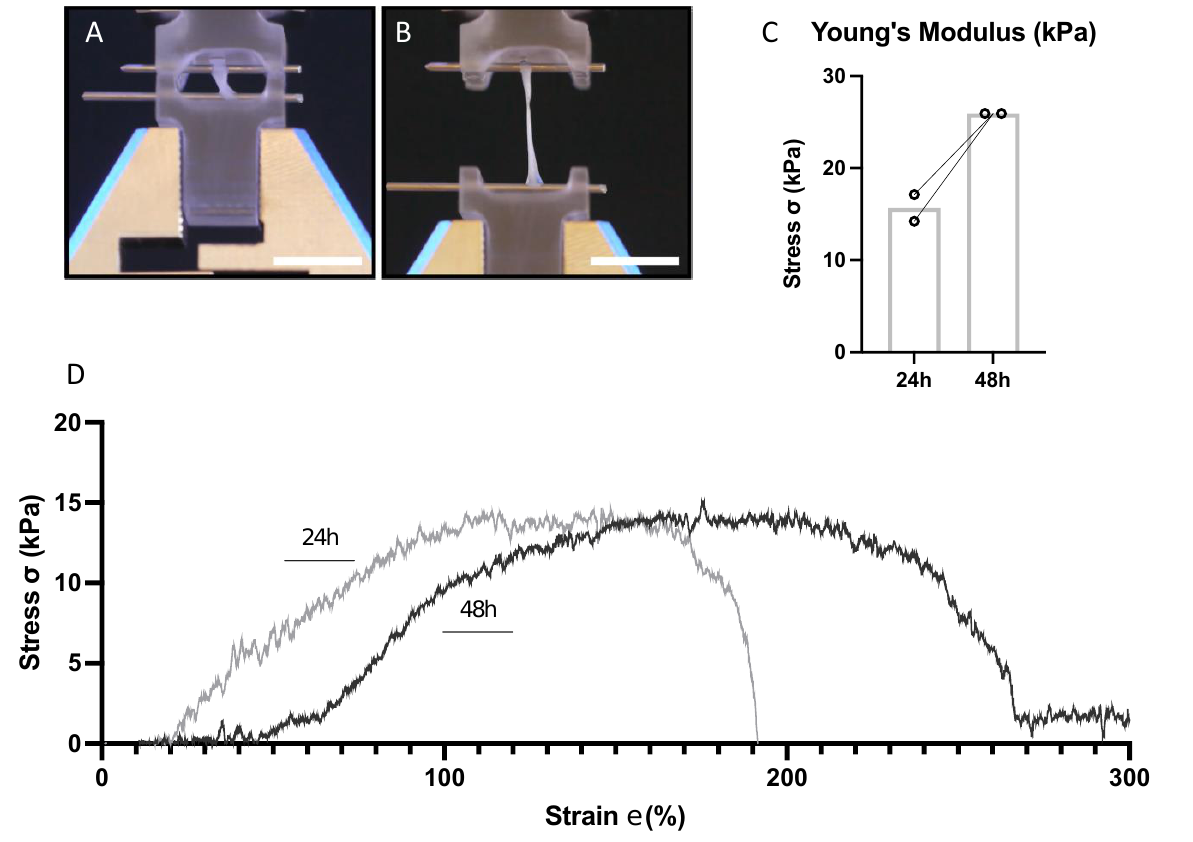
Figure 5. Stiffness measurements of the EHM ring (1.5 mg/mL collagen concentration; 1.000 cells/ µ L gel) at two different timepoints (24 h and 48 h). Images of tensile analysis at 0% elongation ( A ) and at elongation at break; ( B ). Bar represents 10 mm. Tensile stiffness displayed as Young’s Modulus ( n = 2); ( C ); Stress – strain ( σ / ε ) curve of the moving average (20 points/strain value) ( n = 1) after 24 h and 48 h ( D ).